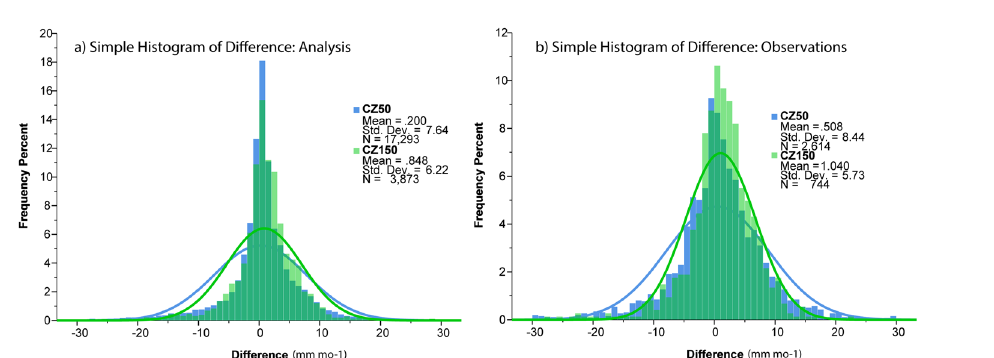
Figure 3. Percentage histograms for all 1971–2010 minus 1931–1970 differences in CZ50 (blue bars) and CZ150 (green bars) in mm mo − 1 . Best fit lines are also drawn for CZ50 (blue line) and CZ150 (green line). ( a ) Is for all analysis grid boxes and ( b ) is for observation grid boxes.